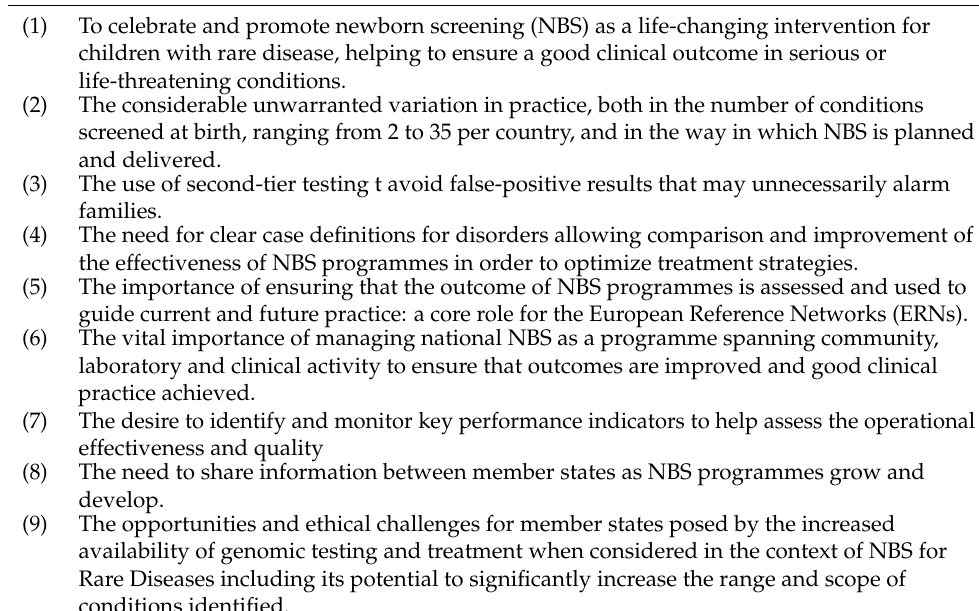
Table 1. The key points identified in stakeholders’ discussion. Abbreviations: NBS—Newborn screening; ERN—European Reference